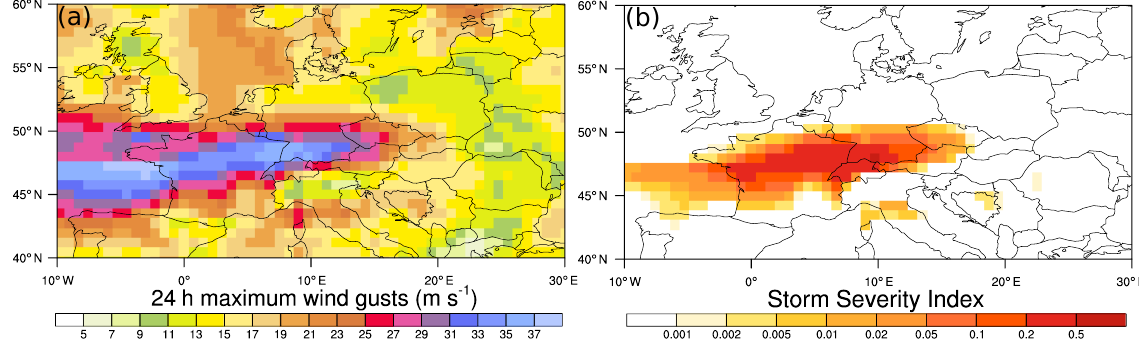
Figure 3. Example of the daily maximum wind gusts (a) and daily Storm Severity Index (b) for storm Lothar in ERA-Interim on 26 Decem- ber